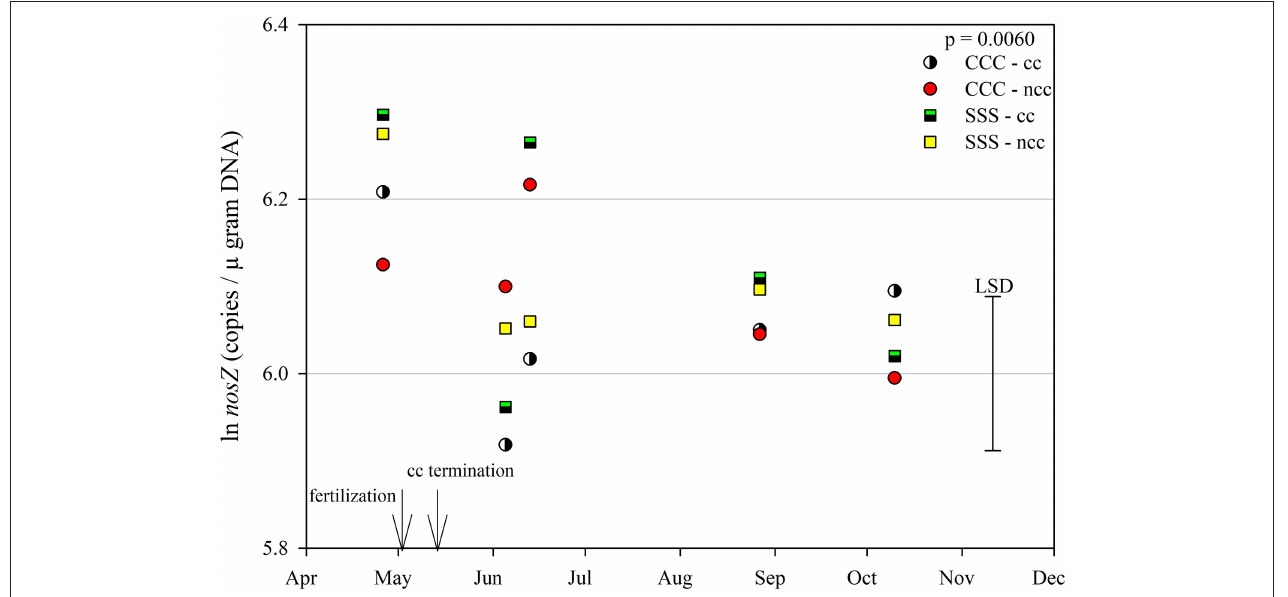
FIGURE 9 | Mean lognormal transformed soil nosZ (copies µ gram DNA − 1 ) throughout the 2019 growing season separated by crop rotation [CCC, continuous corn (circles); SSS, continuous soybean (squares)] and cover crop [CC, cover crop (partial fill); NCC, no cover crop (solid fill)]. Significant differences in treatment means can be interpreted by the Least Square Differences (LSD) error bar to the right of the figure. Mean values that fall beyond the distance of the LSD are significant at α =